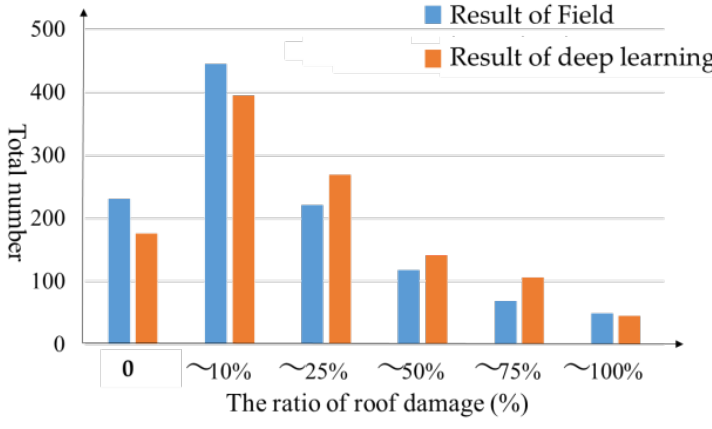
Figure 11. Comparison with field investigation in the proportion of roof